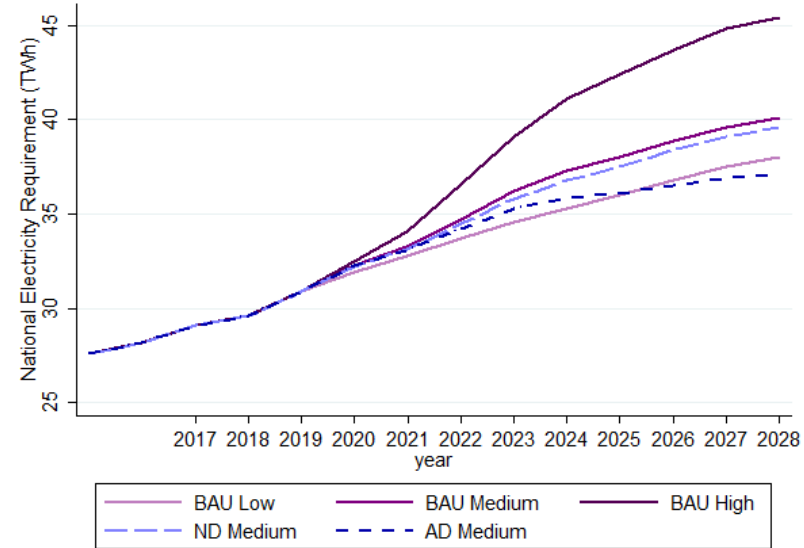
Figure 5. National electricity consumption (TWh). Source: Author’s calculations based on EirGrid [53] data. Note: Assumes a data centre capacity factor of 0.75. Table 3. Data centre share of national electricity